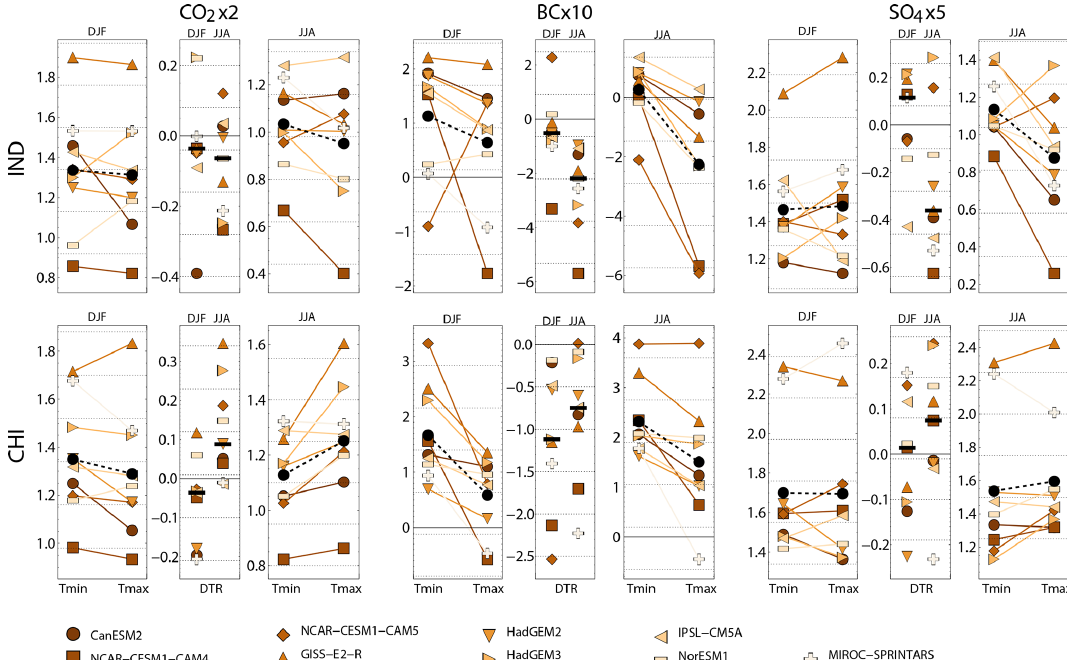
Figure 5. Northern Hemisphere regional changes in DTR, T min and T max for the three drivers (columns) in the two Asian regions IND and CHI (rows). For each driver and region, subpanels show wintertime changes in T min and T max , wintertime and summertime changes in DTR, and summertime changes in T min and T max . The black horizontal bars and circles show the multimodel median changes.